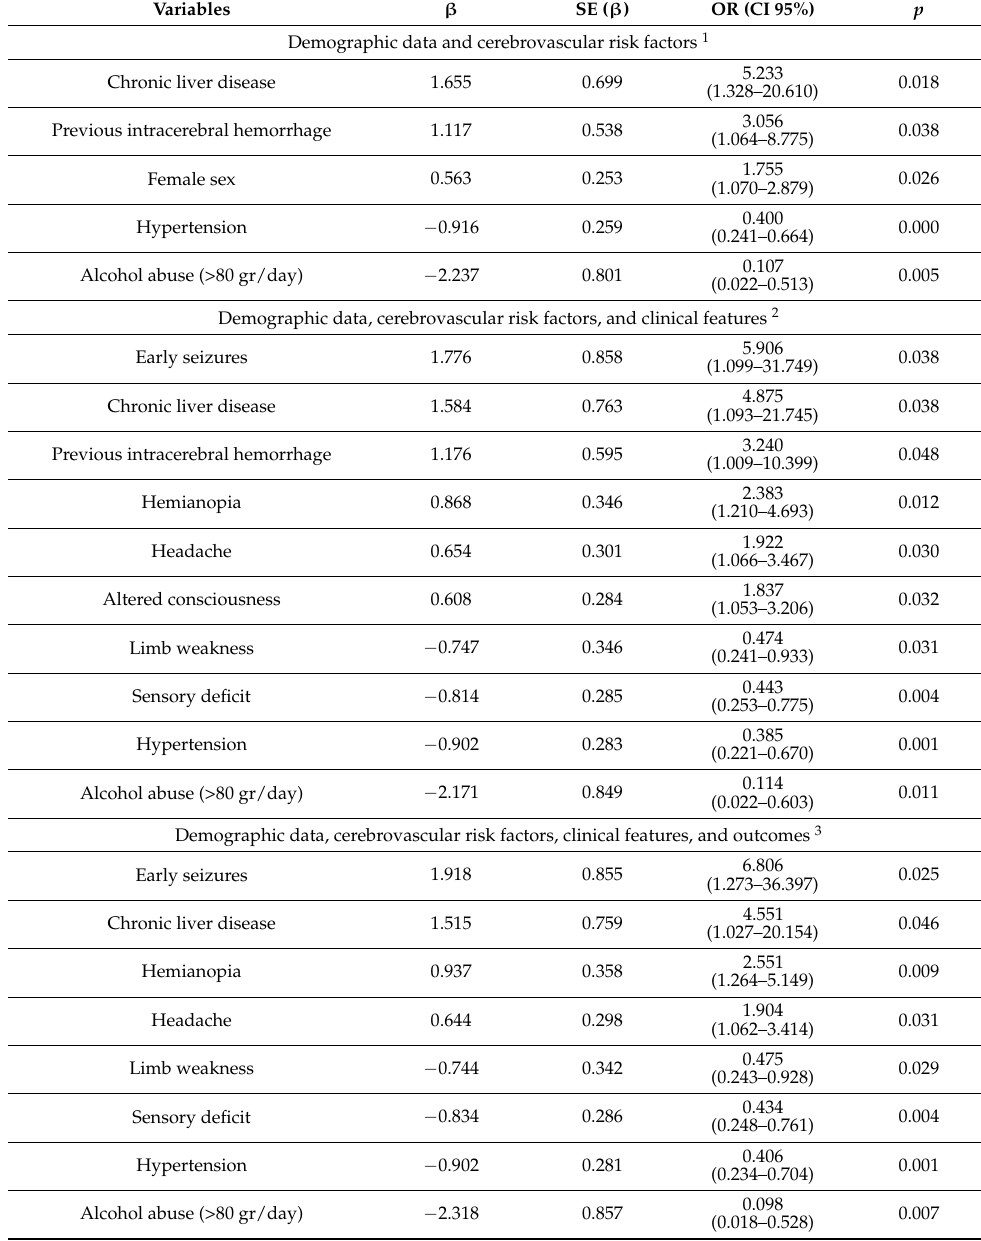
Table 4. Results of multivariate analysis independently associated with lobar hemorrhages in the different logistic regression